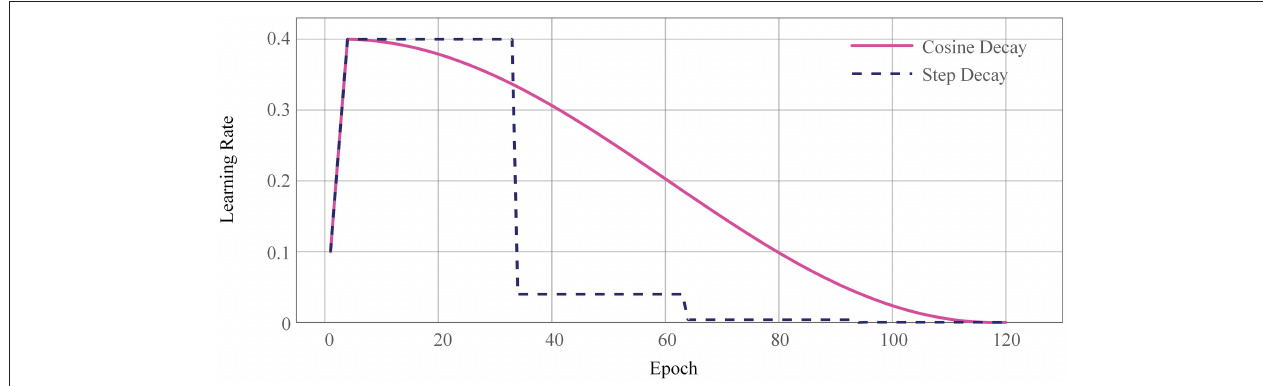
FIGURE 6 | Warm-up learning rate curve. The dashed line corresponds to the segmented constant learning rate; the red curve is the warm-up learning rate decay strategy used in this